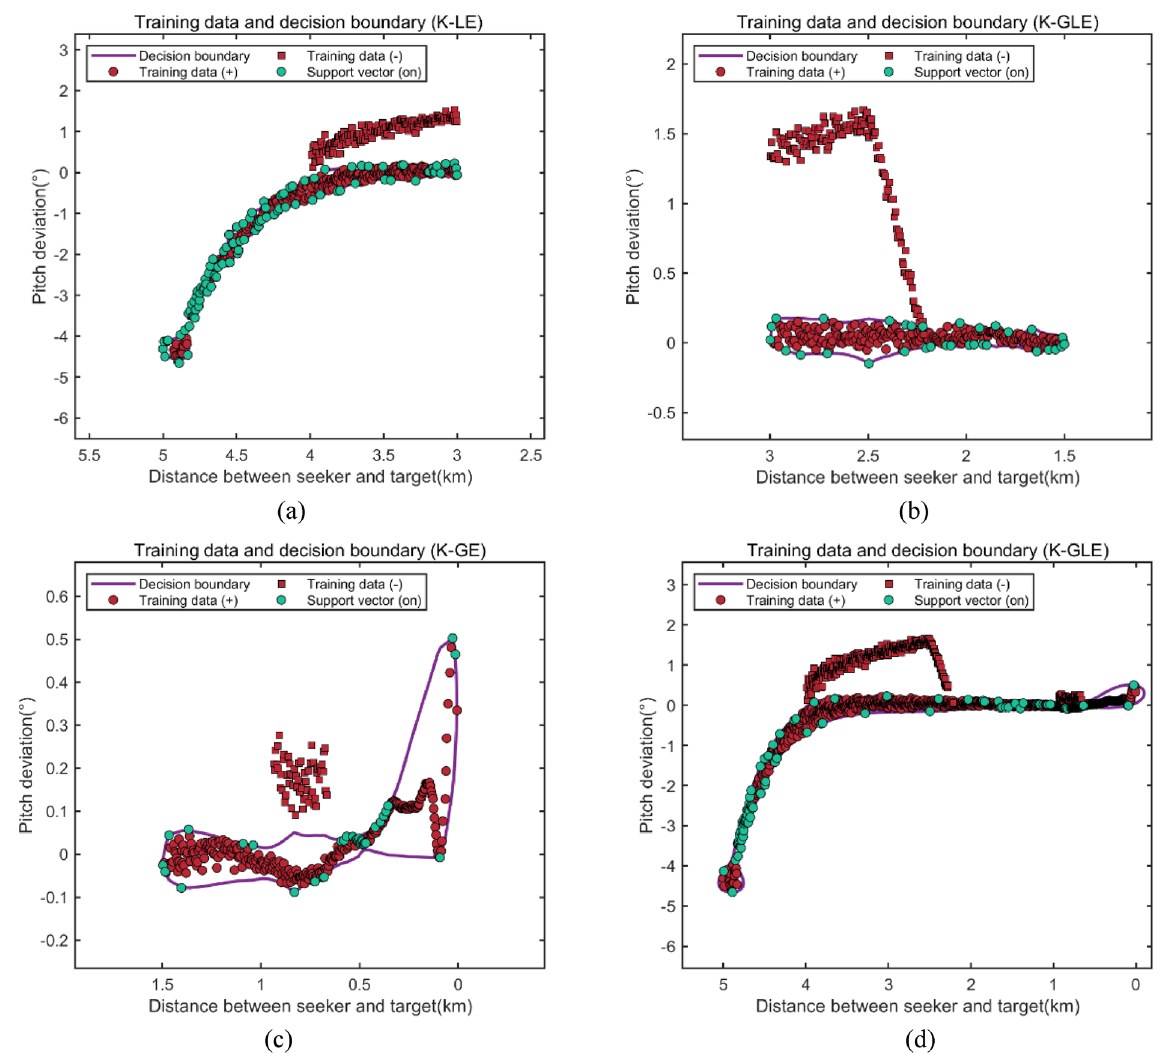
Figure 2. Optimal classification results of outlier detection in different guidance stages. ( a ) Outlier detection in the initial stage of guidance, ( b ) outlier detection in the intermediate stage of guidance, ( c ) Outlier detection in the final stage of guidance, ( d ) Outlier detection in the whole stage of